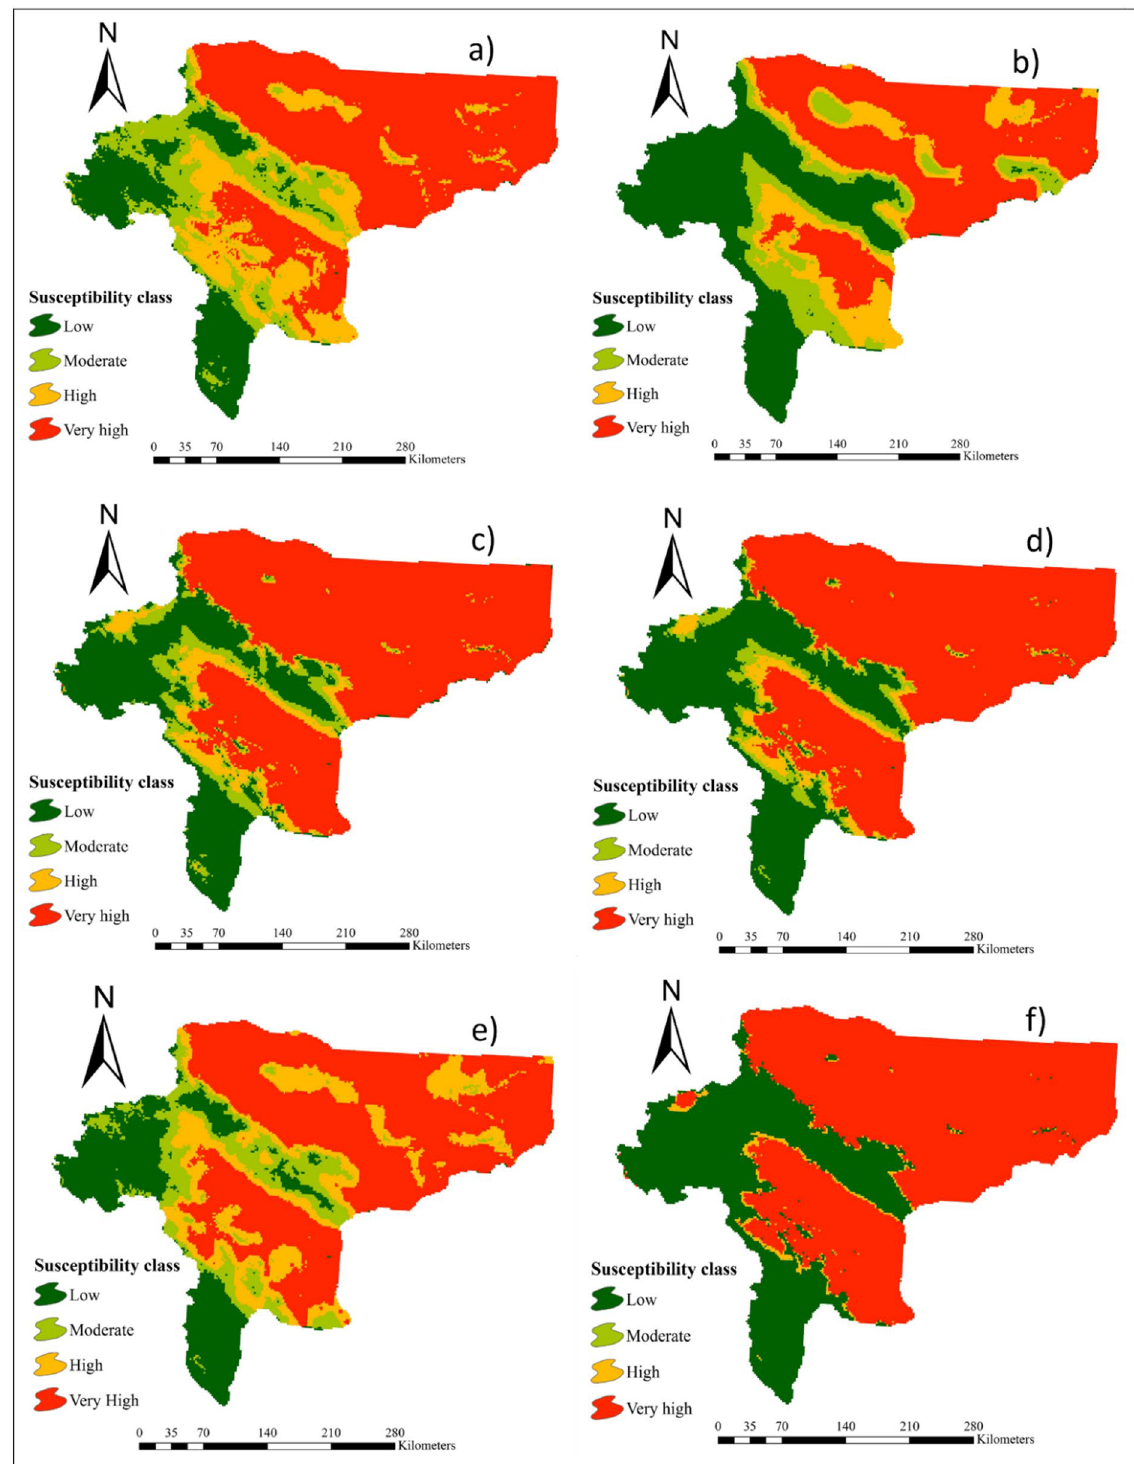
Figure 3. Maps of wind erosion hazard generated by: (a) BGLM, (b) NBGLM, (c) BGAM, (d) SGAM, (e) SSR, and (f) SGB. The values for pixels was estimated by R software (https ://CRAN.R-proje ct.org/doc/FAQ/R-FAQ. html) and then, values of pixels were mapped by ArcGIS 10.4.1 (https ://www.esri.com/en-us/about /about -esri/ overv